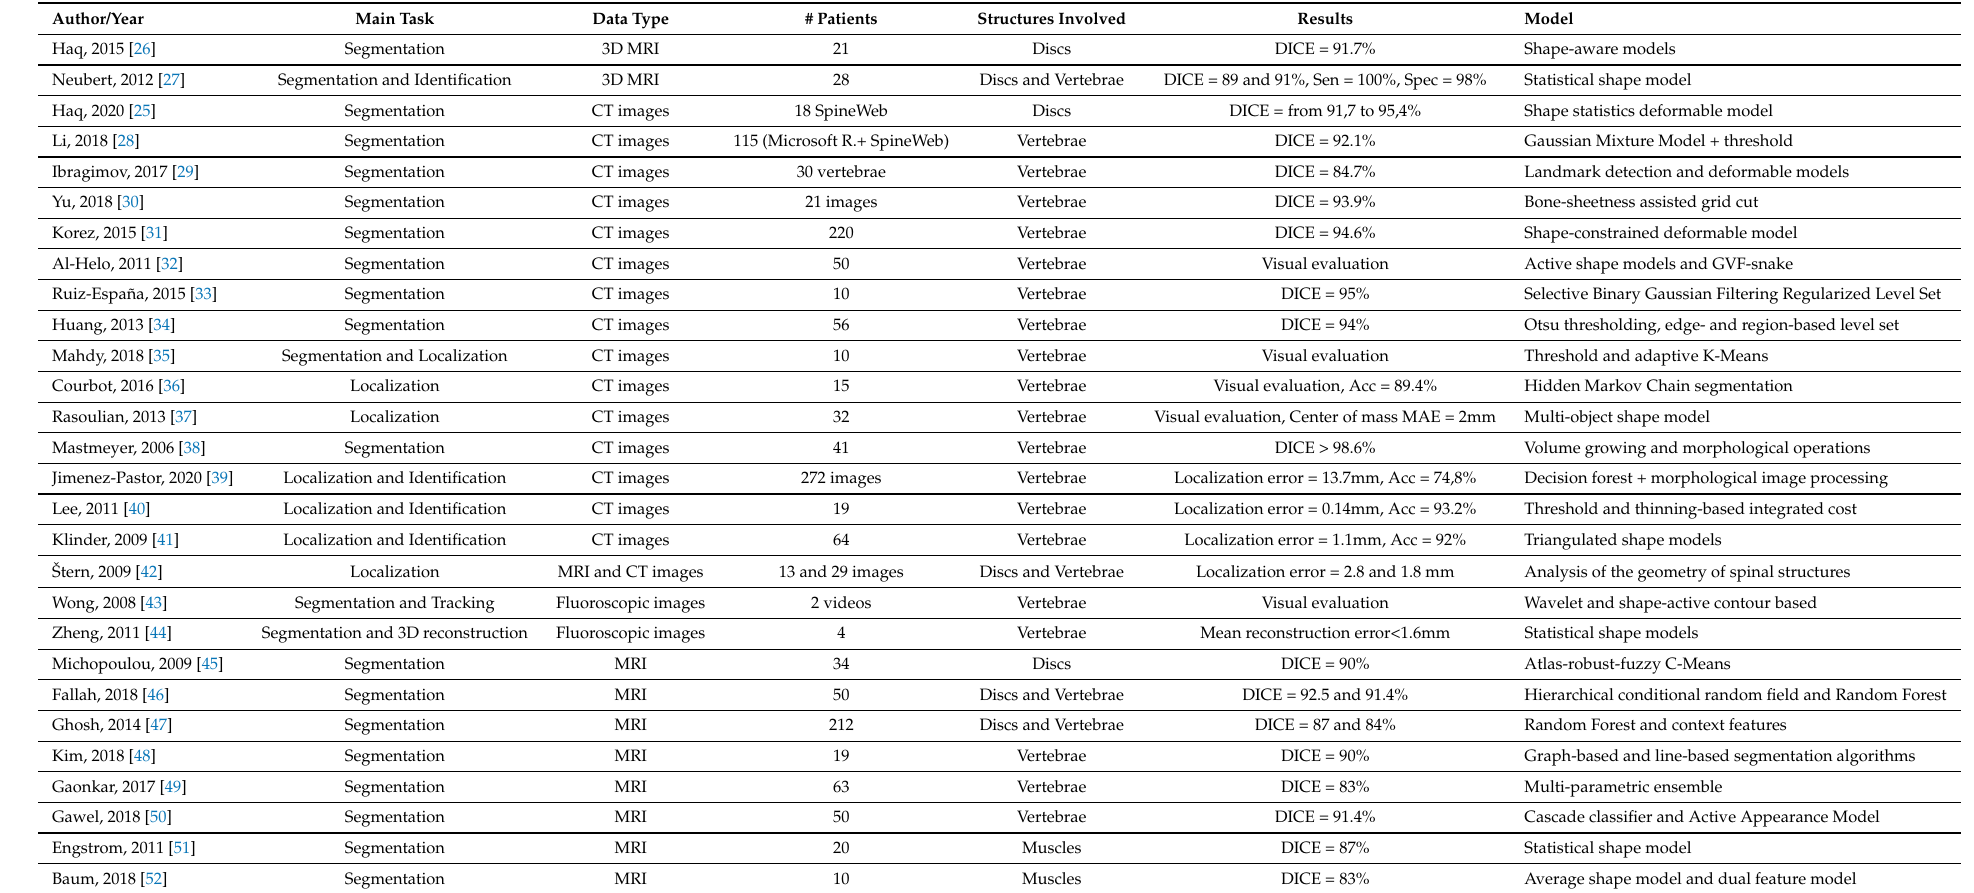
Table 2. Segmentation—Digital Image Processing. For each work, the main task is reported, whether it concerns only the segmentation of lumbar components, or if it aims to localize specific parts (e.g., the center of mass) of the components, or if it aims to identify each component (e.g., differentiating vertebrae between each other). If more structures are investigated, the correspondent results are reported in the same order in which structures are presented in the column “Structures involved”. Abbreviations are used for Magnetic Resonance Imaging (MRI), Computed Tomography (CT), Accuracy (Acc), Sensitivity (Sen), Specificity (Spec), Area Under the Curve (AUC), Gradient Vector Flow (GVF), Support Vector Machine